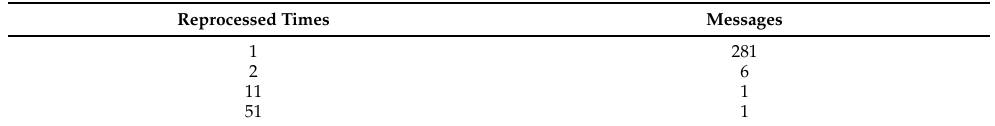
Table 20. Re-processed